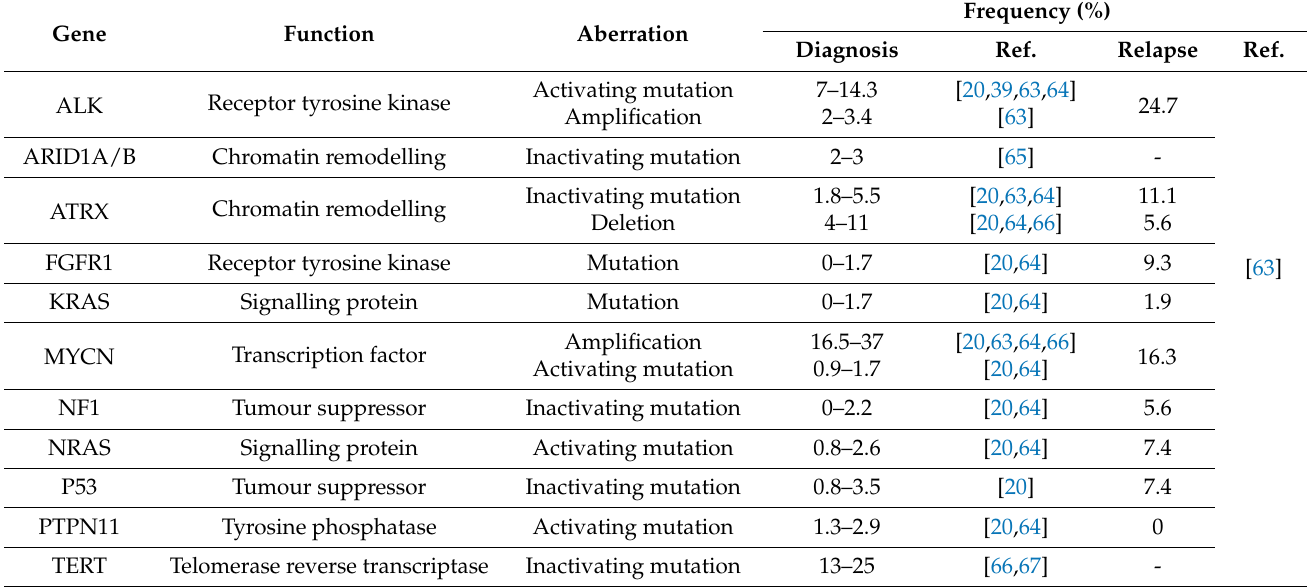
Table 2. Frequency of notable genomic aberrations observed in